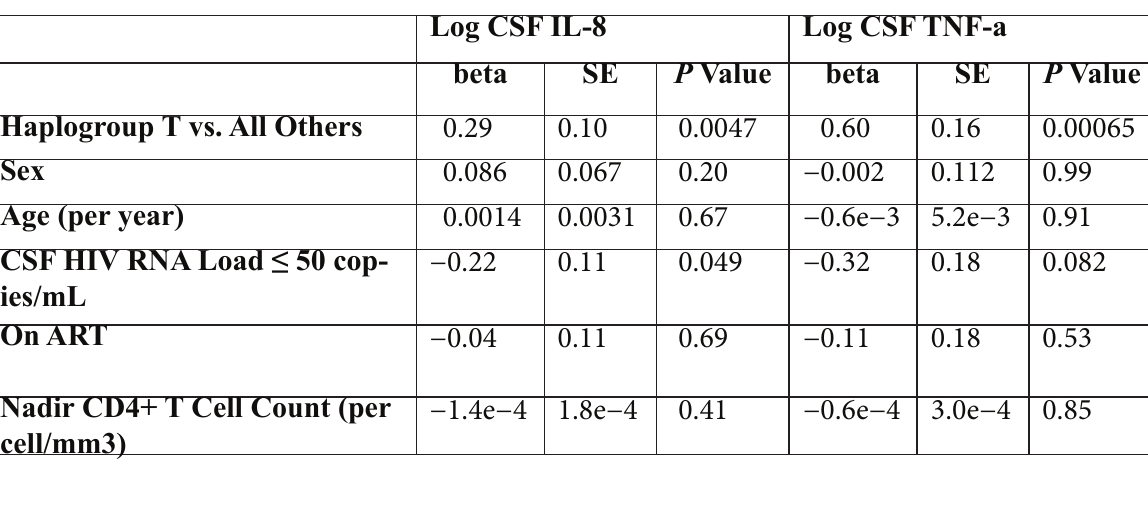
Supplemental Table 5. Multivariate linear regression results for log CSF IL8 and TNF-α with mitochondrial haplogroup T for participants with contributing morbidity for neurocognitive im - pairment.